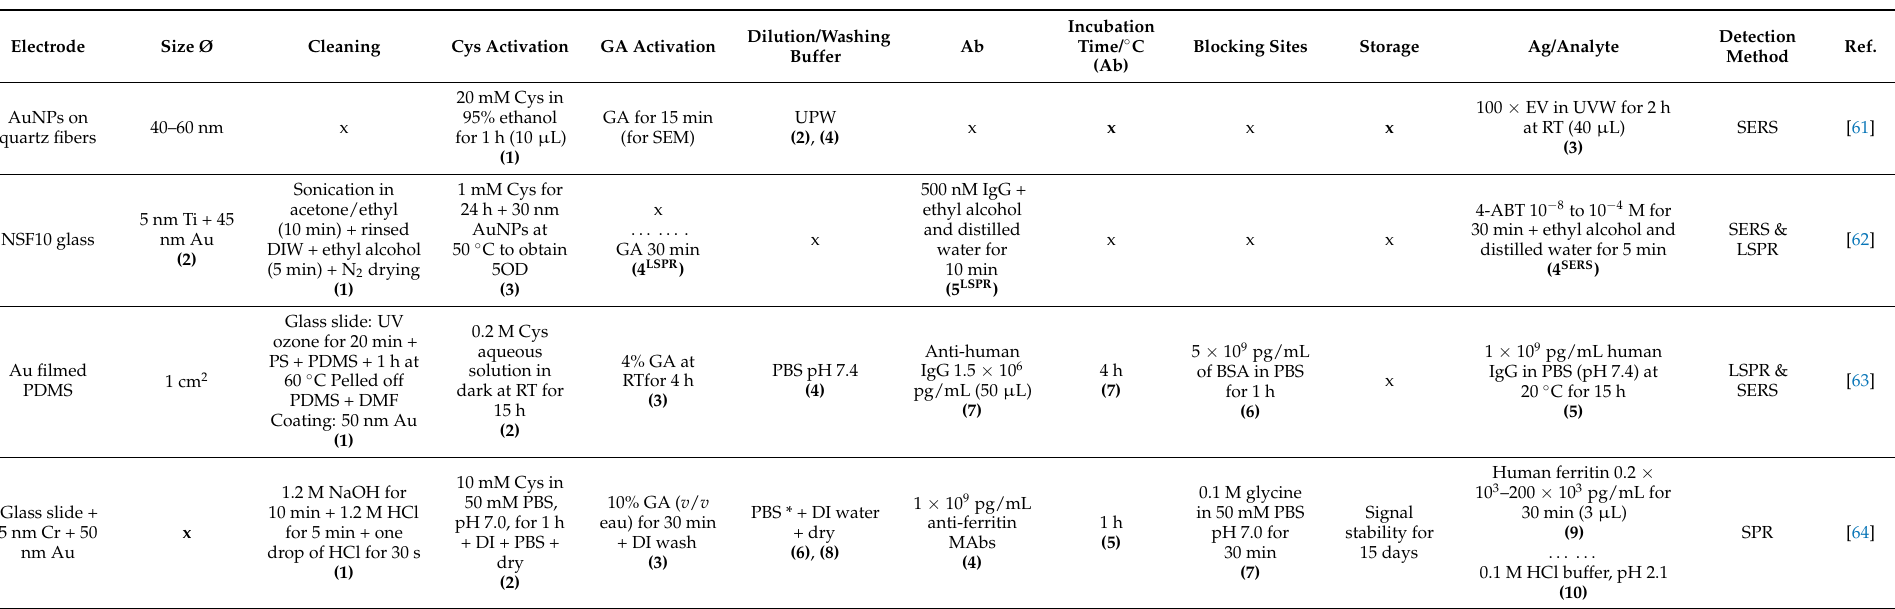
Abbreviations: DMF—dimethylformamide; EV—extracellular vesicles; SEM—scanning electron microscopy; OD—optical density; 4-ABT—4-aminobenzenethiol; * PBS composition: 5 mM